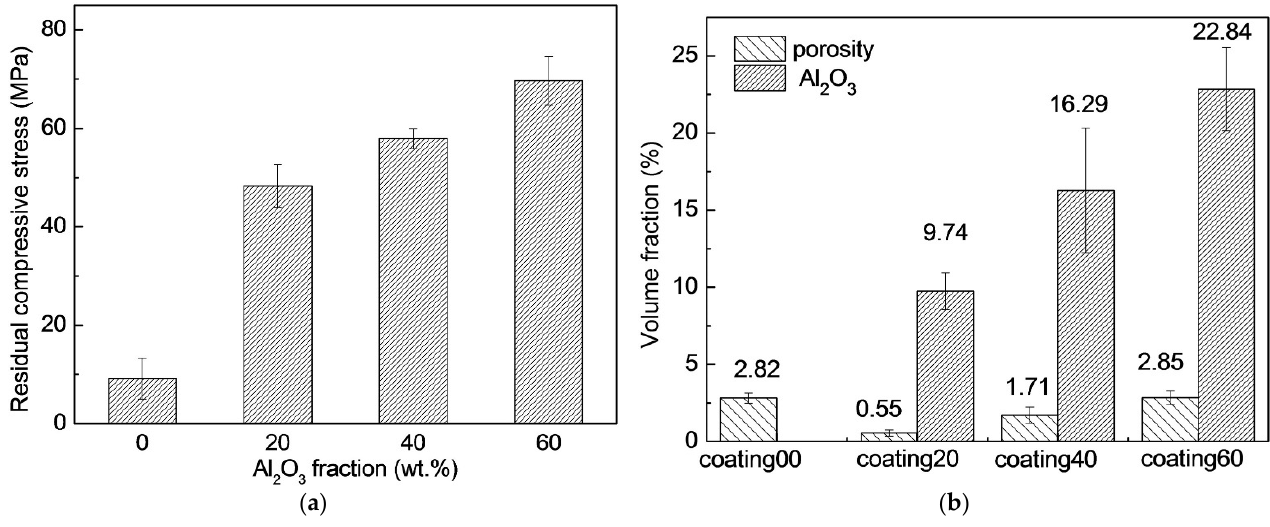
Figure 12. Residual compressive stress variations with different Al 2 O 3 weight fractions (wt.%) on the surface layer ( a ), porosity and Al 2 O 3 volume fraction ( b ) of the coatings. Reprinted with permission from [140]. Copyright 2019 Elsevier.